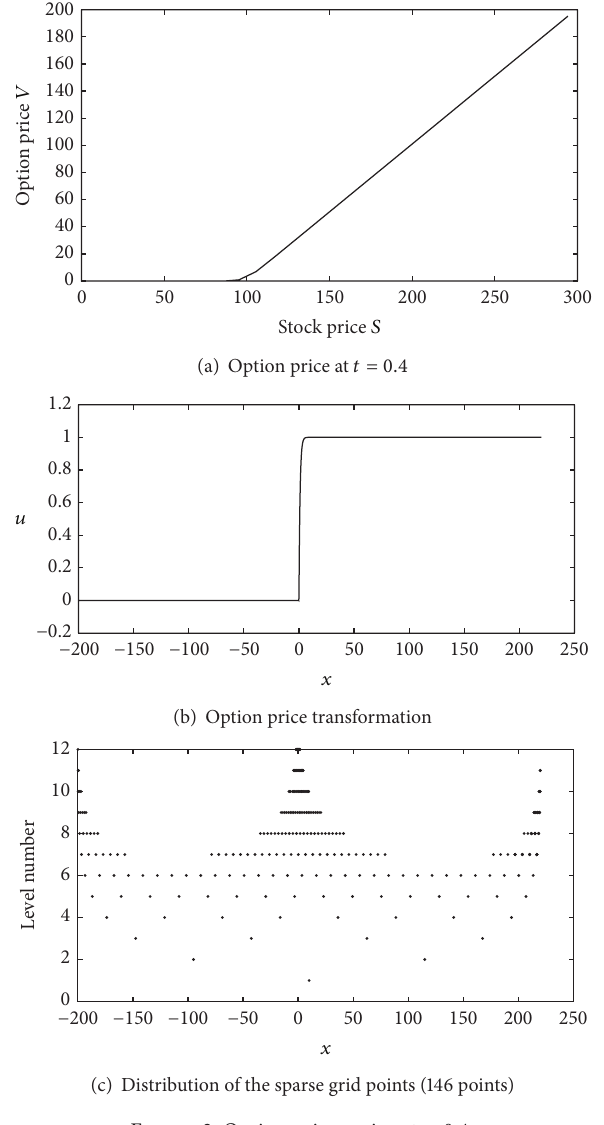
Figure 2: Option price at time 𝑡 = 0.4 .